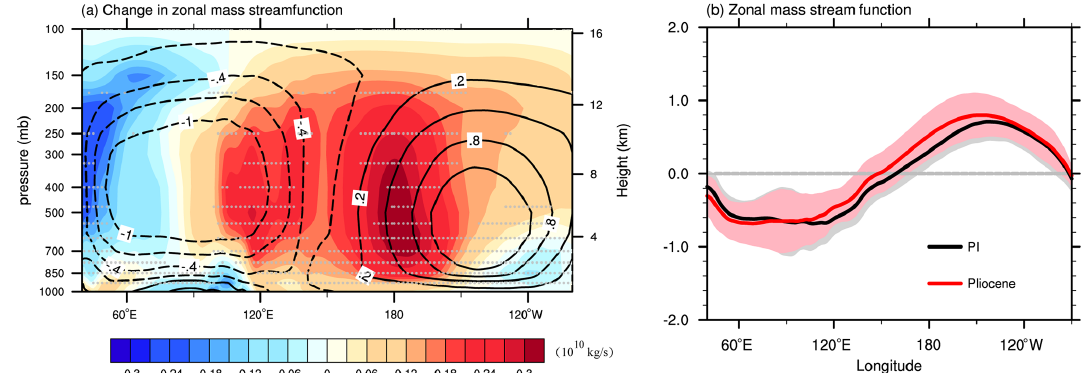
Figure 11. (a) Changes in ZMS (shading; in 10 10 kgs − 1 ) averaged between 10 ◦ S and 10 ◦ N for the mid-Pliocene with respect to the PI simulation, overlaid by the climate mean ZMS for the PI simulation (contours). The zonal wind V Z is used to calculate ZMS, which is decomposed from the 3P-DGAC method. The contours represent the climate mean ZMS for the PI simulation. Solid curves indicate a positive value, and dashed curves show a negative value. Stippling indicates regions where at least 10 of 13 simulations in the model group agree on the sign of the ensemble mean. Panel (b) shows the vertically integrated ZMS from panel (a) . The gray and pink shading indicates 1 standard deviation of individual models’ departure from the MMM mean of the MSF for the PI and mid-Pliocene simulations, respectively.